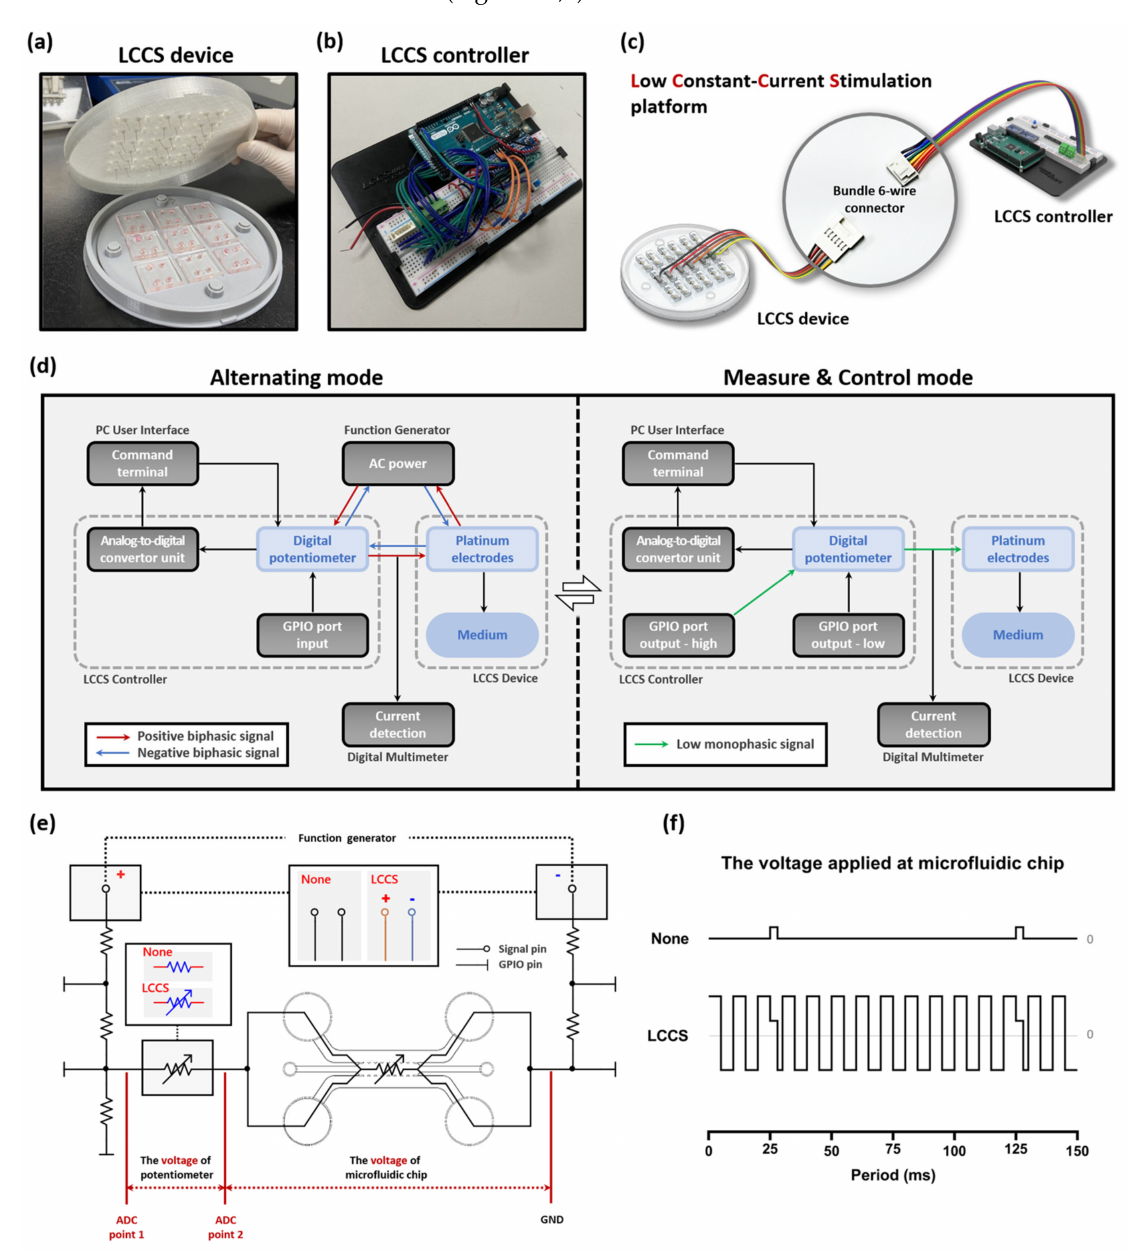
Figure 2. Components of the LCCS platform with inter-operational processes, including the alternating, measure, and control mode. The LCCS platform is composed of ( a ) the LCCS device and ( b ) the controller. ( c ) The LCCS device and controller are connected with bundle 6-wire connectors to send and receive signals. ( d ) The block diagram elucidates the operational process of the LCCS platform and the two modes allowing the alternating, measure, and control modes. ( e ) To analyze the impedance changes and validate the functionality of the LCCS, the transformation of circuits in the controller was conducted under two conditions (None/LCCS). ( f ) Comparison of the voltage waveform for two conditions (None/LCCS). None, condition without constant-current stimulation. LCCS, condition with constant-current